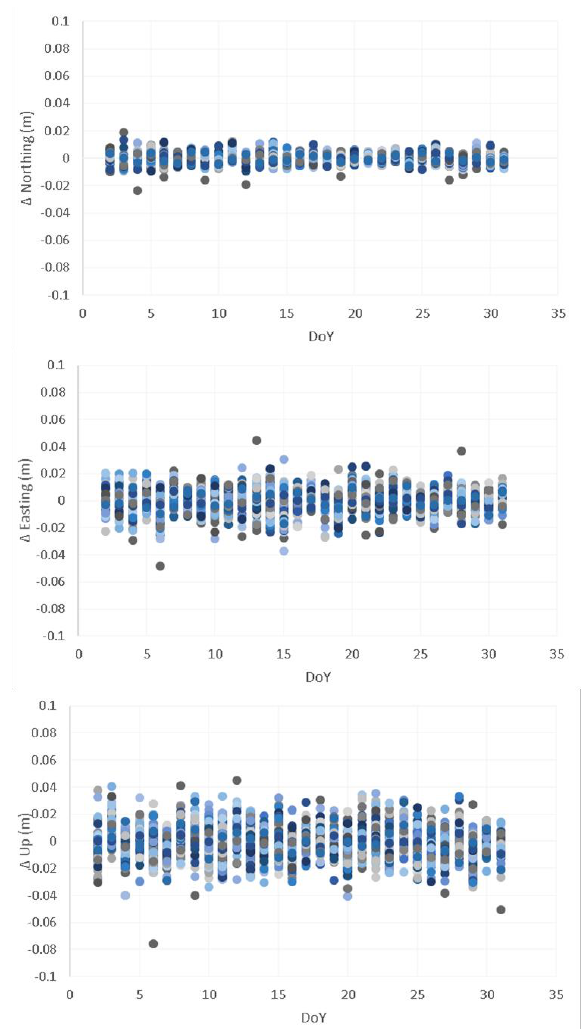
Figure 3. Repeatability of each MyRTKnet station in horizontal and vertical